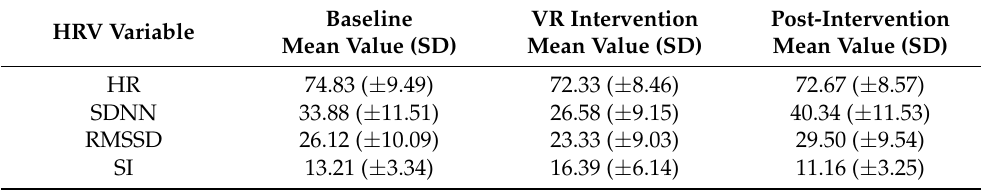
Table 1. Mean values of HR, SDNN, RMSSD, and Stress Index (SI) from 12 participants in three five-minute measurements, recorded during baseline measurement, while using Binaural Odyssey, and after the virtual reality intervention. HRV